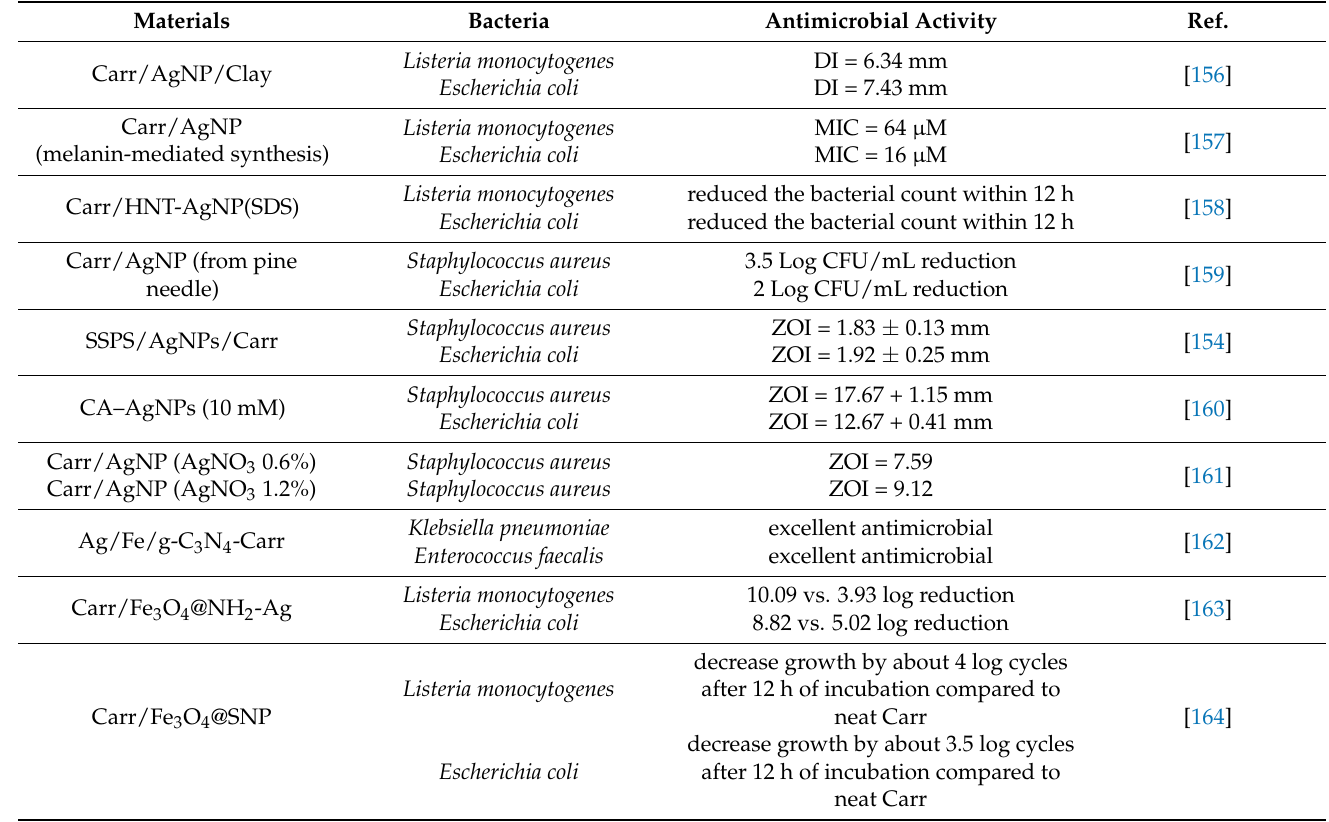
Table 2. Antibacterial composites and polymer blends of